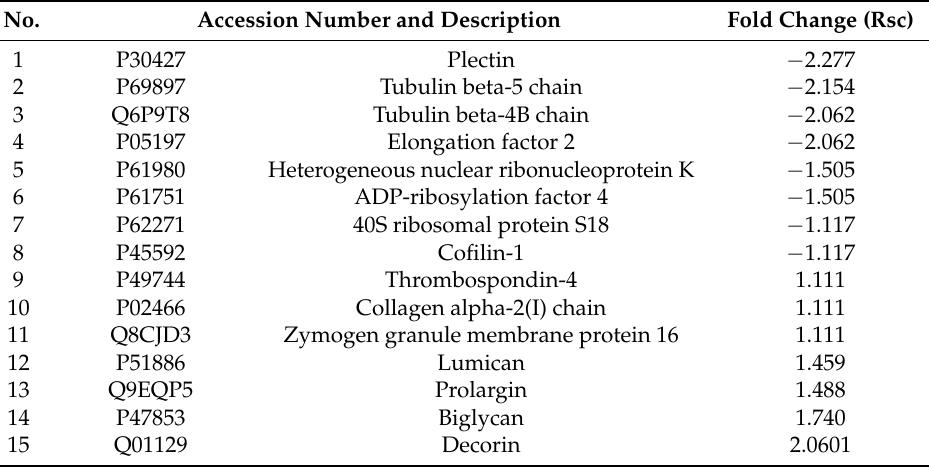
Figure 2. Semiquantitative comparison of proteins differentially expressed in the cornea of the STZ rat. For the identified proteins, Rsc and normalized spectral abundance factor (NSAF) values were calculated to compare protein expression levels between the cornea of normal rat (Normal) and that of the STZ rat (STZ). Proteins are positioned along the x-axis according to Rsc value, increasing from left to right (light gray area). NSAF values are shown for the Normal group (below the axis; gray bar) and for the STZ group (above the axis; black bar). Proteins highly expressed in the Normal and STZ groups are near the left and right sides, respectively of the x-axis. Housekeeping proteins are located around the center of the x-axis. Table 1. Proteins categorized as “extracellular matrix” in Gene Ontology